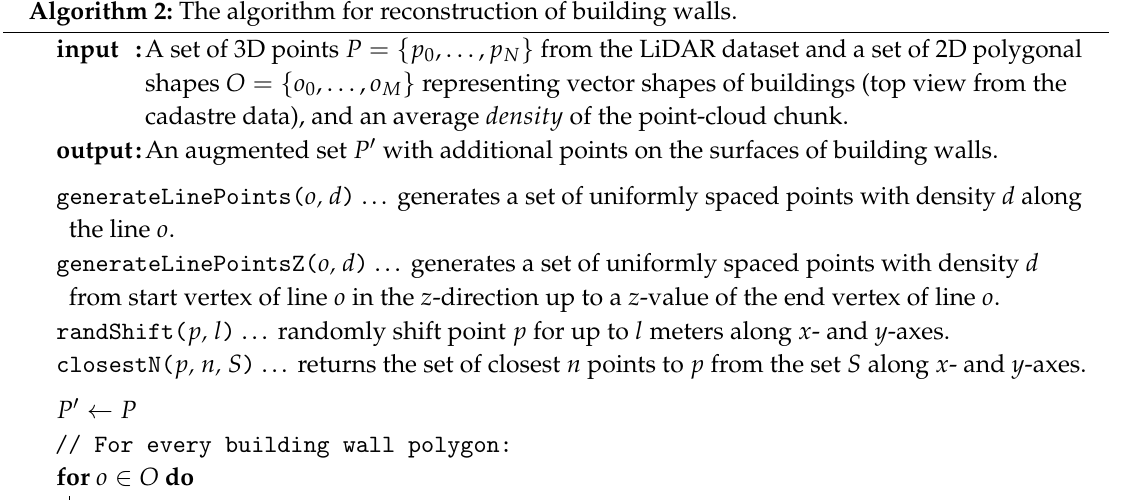
Algorithm 2: The algorithm for reconstruction of building